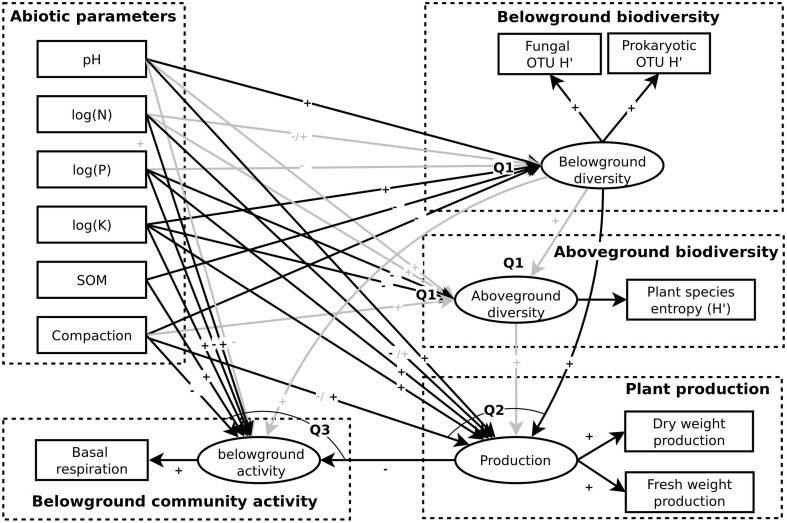
Structural Equation Model (SEM) derived from the theoretical meta-model of the community (see Figure 1) and corresponding questions targeted. Latent variables are illustrated as ellipses, exogenous variables are as boxes and theoretical constructs as boxes with dashed lines. Causal links indicated as significant in the total or group-wise (M only) best-fitting maximum likelihood solution to the model (see Table S4) are indicated in black while others are indicated as gray. Positive or negative correlations are indicated by ± signs and when differing between the fit for the total dataset and M both are indicated.